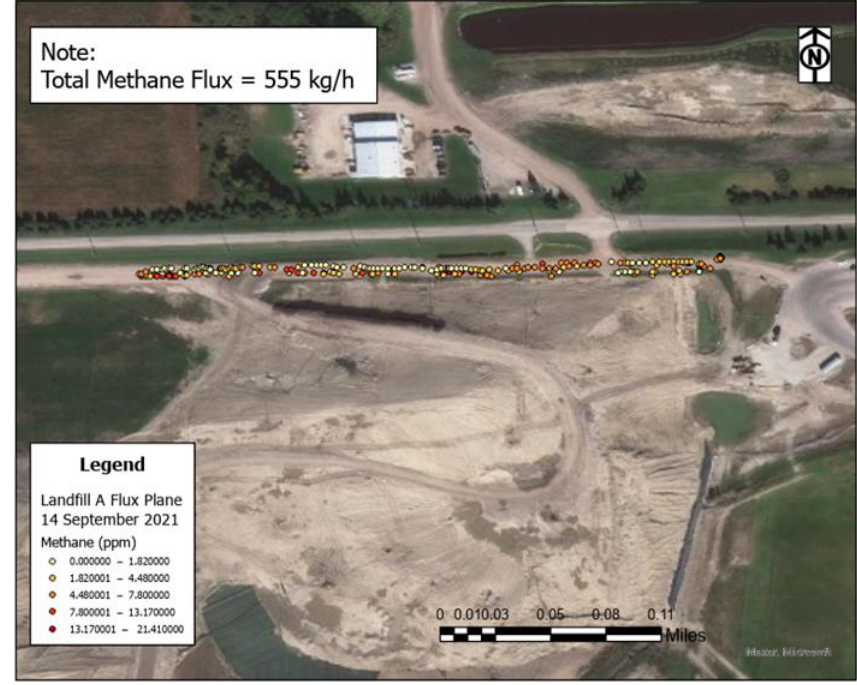
Figure 9. Methane concentrations measured at the downwind edge of Facility A on 14 September